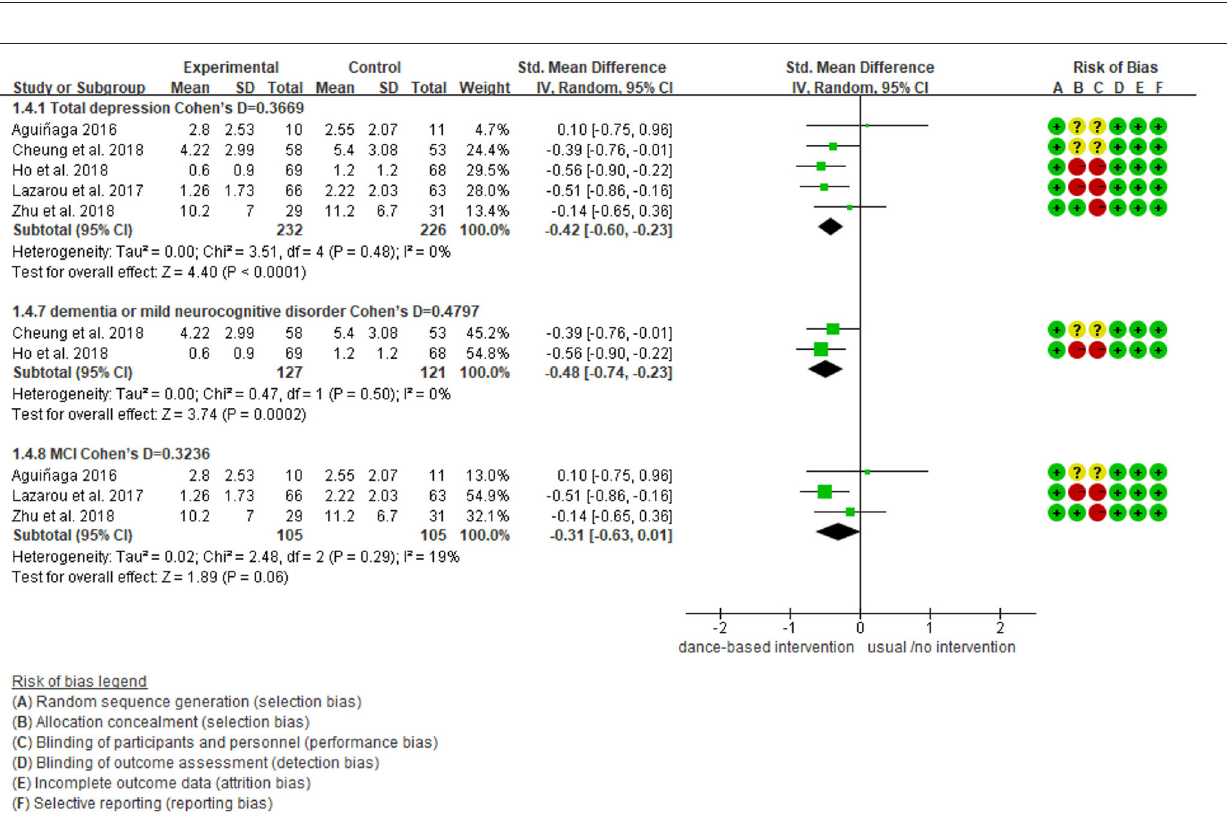
FIGURE 4 | Subgroup analyses of the intervention group vs. the control group on depression rating scores: Disease.